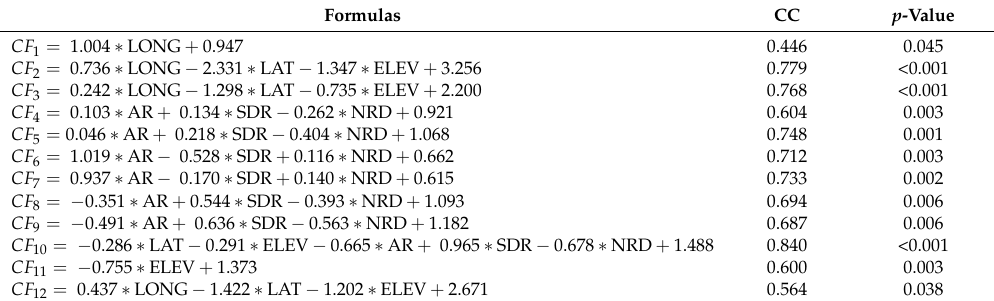
Table 7. Multiple linear models to predict correction factors of TMPA 3B42V7